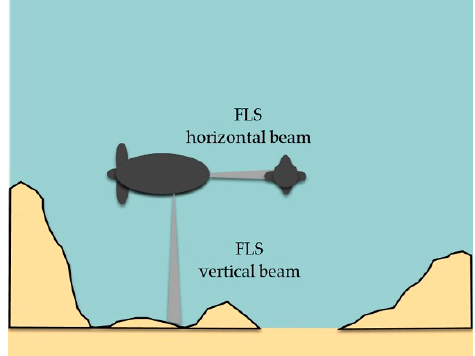
Figure 5. Forward Looking SONAR (FLS) placed at vertical and horizontal orientations.